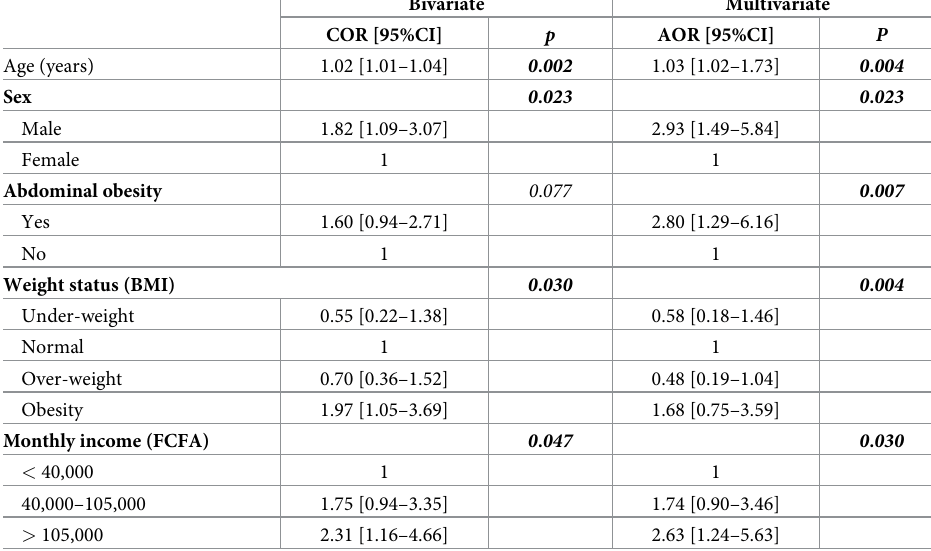
Table 3. Final multivariate analysis model of factors associated with hyperglycemia in rural population of Tanv è and De´kanmey in Benin in